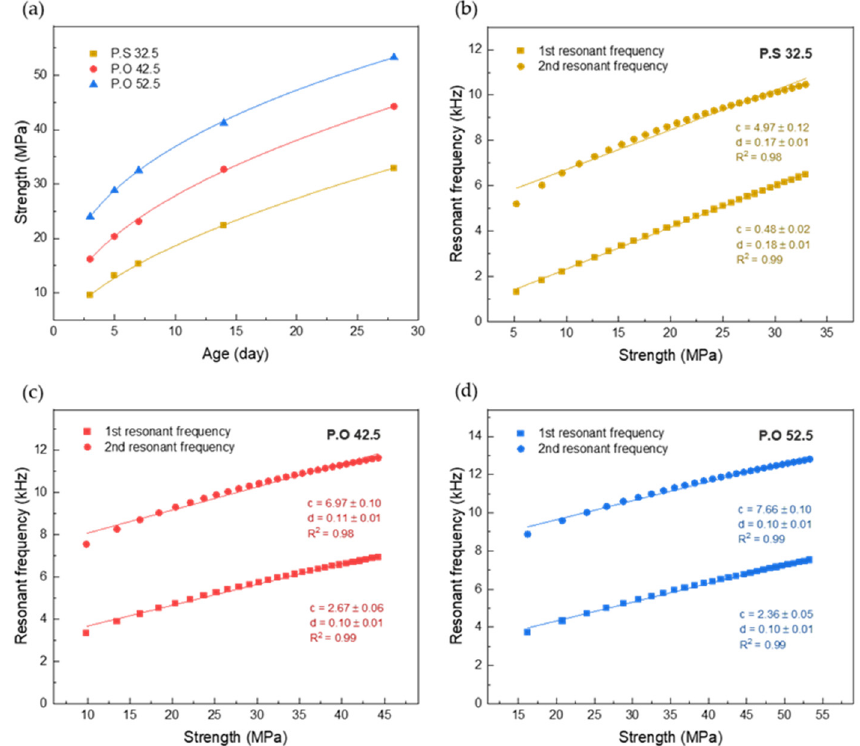
Figure 8. The cement mortar compressive strength and eigenfrequency value during curing time: ( a ) The variation of cement mortar compressive strength over time; ( b ) The variation of P.S 32.5 cement resonant frequency with strength; ( c ) The variation of P.O 42.5 cement resonant frequency with strength; ( d ) The variation of P.O 52.5 cement resonant frequency with